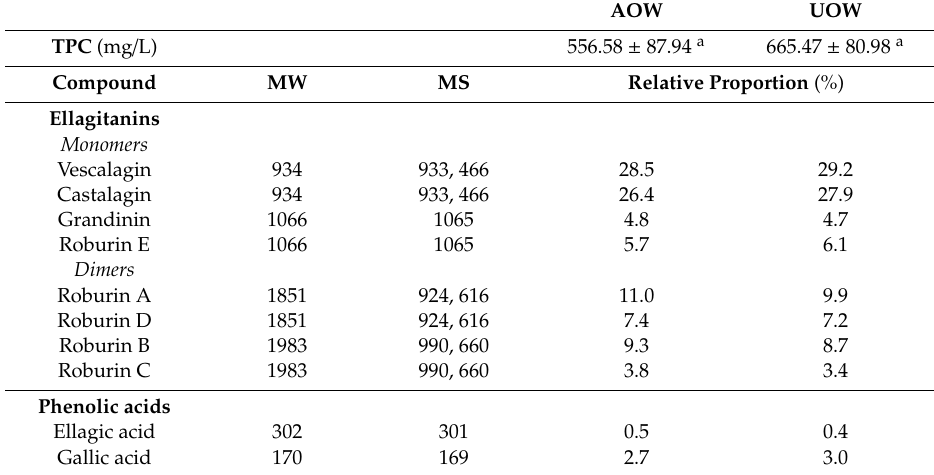
Table 1. Total phenolic content and distribution of ellagitannins and phenolic acids identified by ultra-high-performance liquid chromatography / mass spectrometry (UHPLC / MS) in the oak phenolic extracts from American (AOW) and Ukrainian (UOW) shavings.